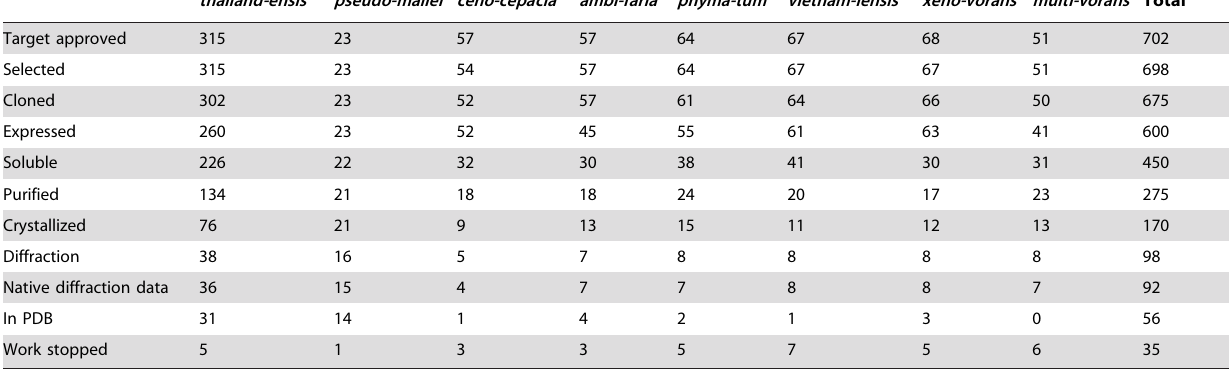
Table 2. Target progress by Burkholderia